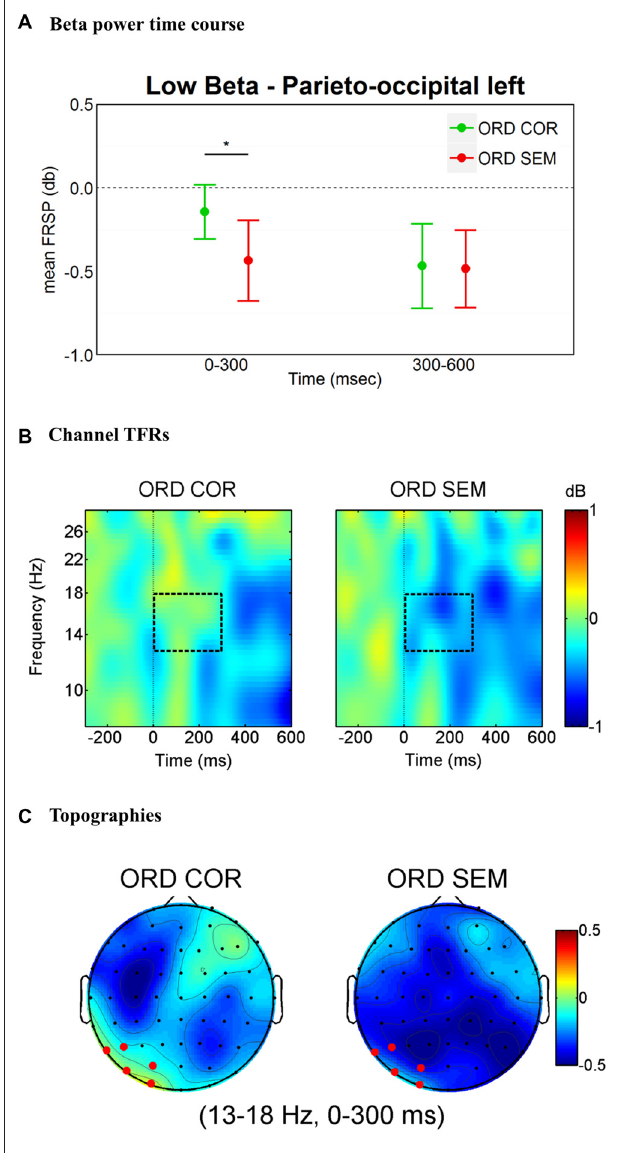
FIGURE 2 | Lower-beta band (13–18 Hz) effects time-locked to the onset of the first fixation on the target word. (A) Left parieto-occipital cluster average lower-beta band power measures in the time windows of interest (0–300 ms and 300–600 ms). Error bars represent 95% confidence intervals. Significant differences between conditions are marked with asterisks: * p < 0.05. (B) Time-frequency (TF) representations of power changes in the target word level analysis. The black rectangle indicates the time and frequency range of interest at one representative channel (PO3). (C) Topographic maps of power change in the 0–300 ms time window. In red, the cluster of electrodes that showed a significant difference in lower-beta band activity when participants read semantically unrelated words as compared to the semantically correct target words.